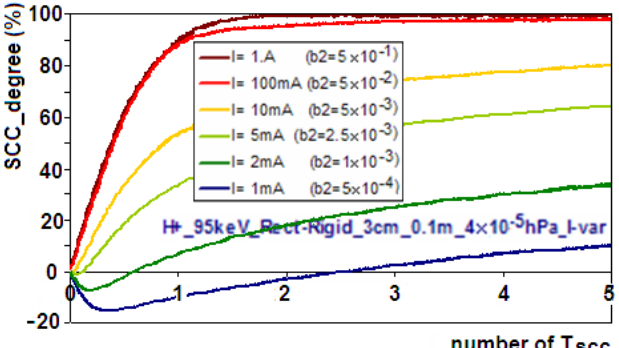
FIG. 6. (Color) SCCD of the H (cid:1) beam for various intensities.